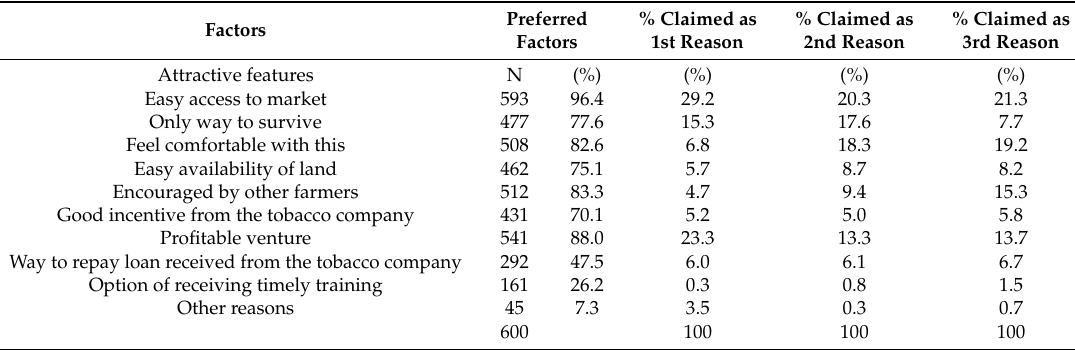
Table 16. Influencing factors for tobacco